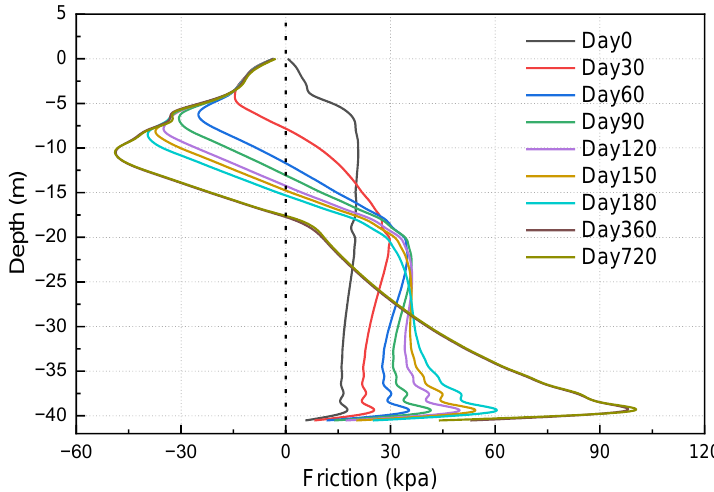
Figure 7. Friction dis tribution evolution of the pile driven immediately after filling (times in the